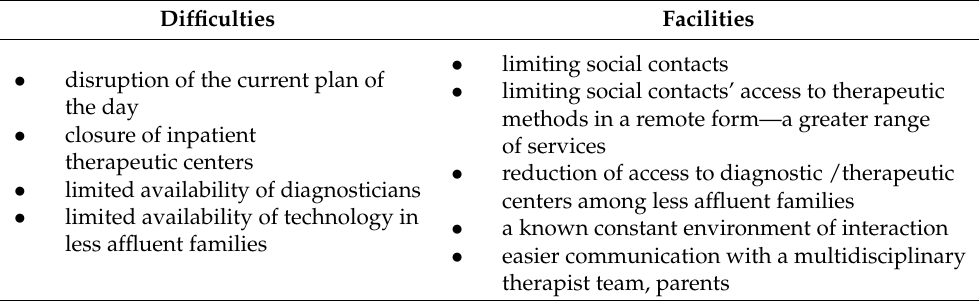
Table 1. Difficulties and facilities for children/adolescents diagnosed with ASD during the COVID-19